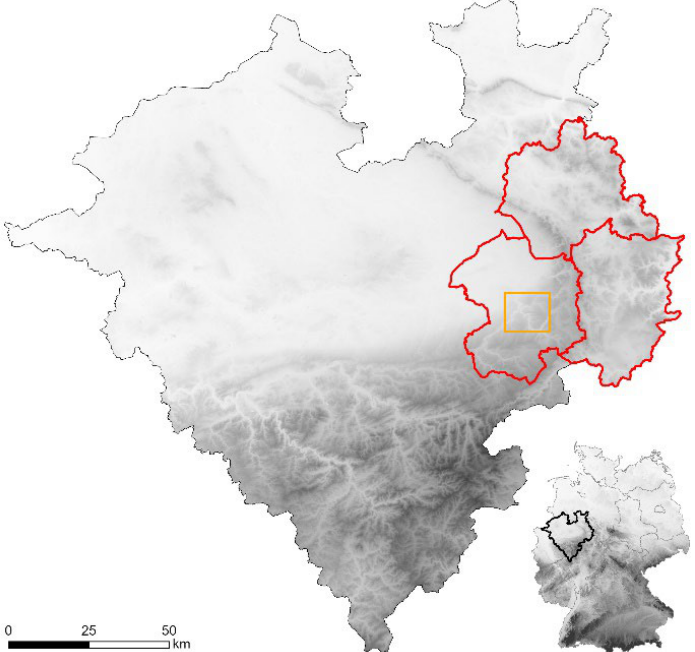
Figure 2. Location of Westphalia and Lippe, the area of responsibility of the LWL archaeological institute, within Germany (black). The general study area is highlighted in red, and the CNN training area is highlighted in orange. Data source: [25,27].